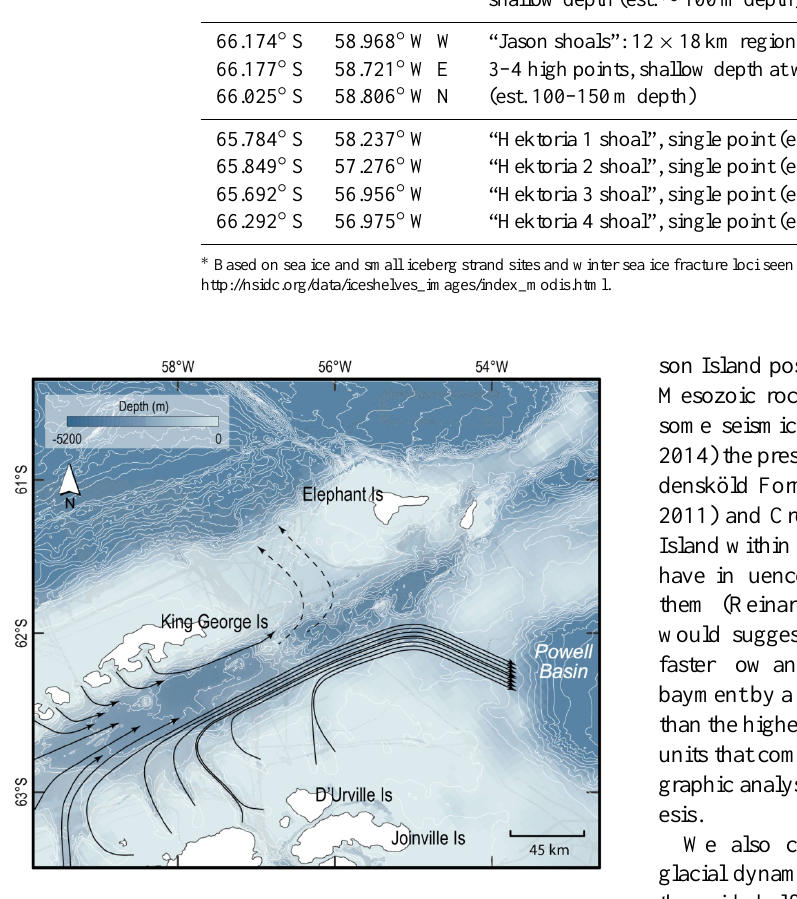
Figure 6. Seabed morphology in Bransfield Strait showing the in- ferred paleo-flow-line trajectories based on the multibeam imagery (black arrows) and assumptions (black dashed arrows). Background image is from BedMap2 (Fretwell et al., 2013); the island coast- line is from the British Antarctic Survey (BAS; http://www.add. scar.org/); the bathymetry contour interval of 250m is from IBCSO (Arndt et al.,